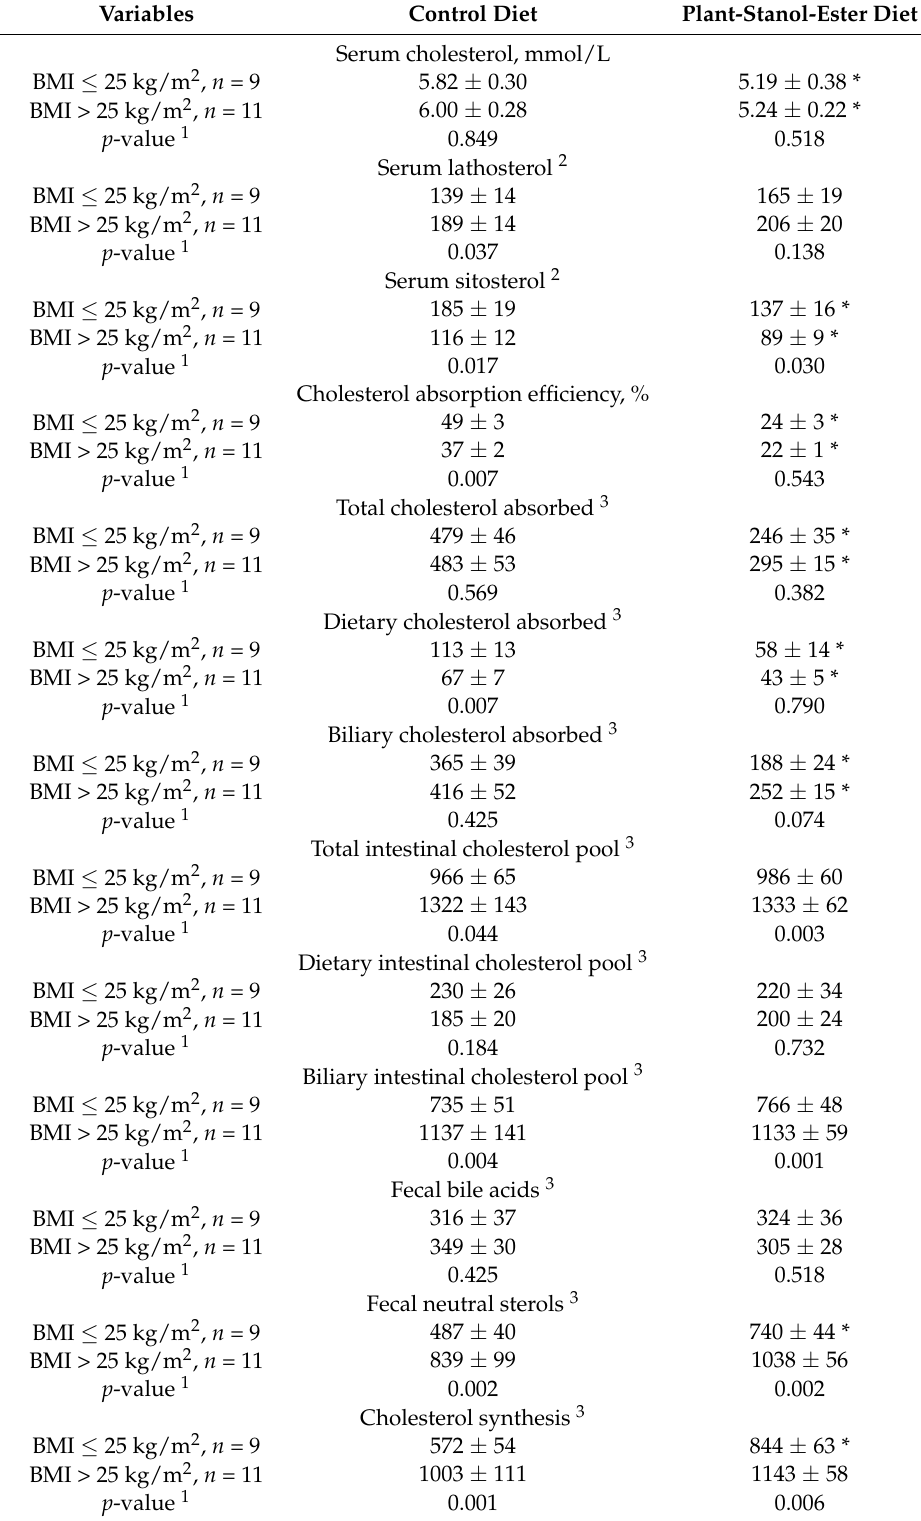
Table 2. Serum sterol concentrations and variables of cholesterol metabolism in the study population divided into normal-weight (BMI ≤ 25 kg/m 2 ) and overweight/obese (BMI > 25 kg/m 2 ) subjects at the end of the control and plant stanol ester